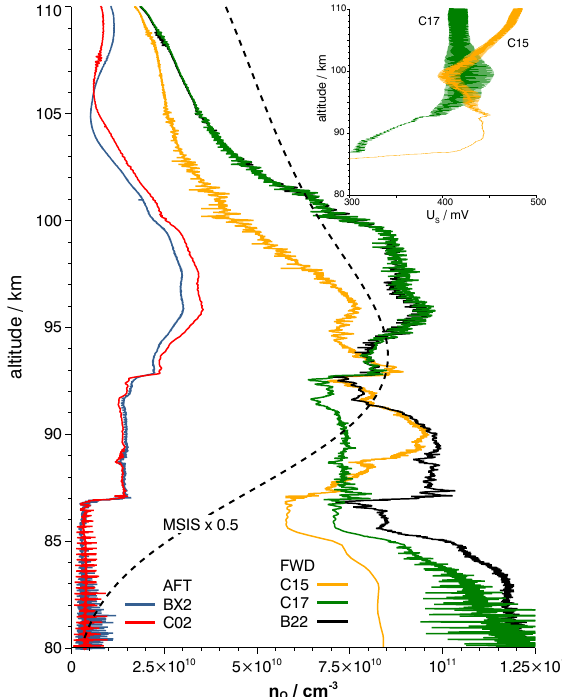
Figure 16. Comparison of O number density profiles from sensors on fore and aft deck during the downleg after aerodynamic correc- tion (ram factors for aft, wake factors for fore). The MSIS profile is scaled by 0.5 and plotted additionally. The inset shows the course of the sensor voltage U S (including 2.9Hz modulation from rocket spin) for two fore